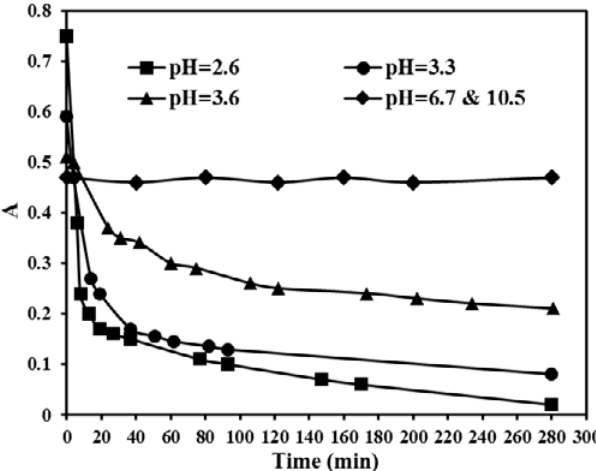
Fig. 9. Degradation studies of a 6.5 ppm aqueous solution of methyl orange over LaMnO condition at 25°C. The pH of the solution was adjusted by addition of dilute solution of HNO